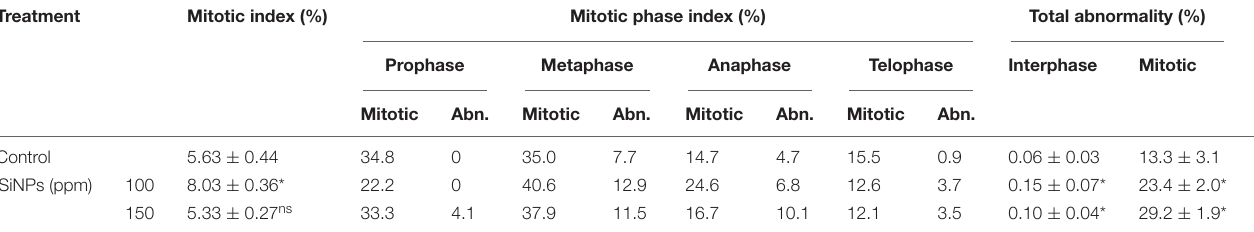
Treatment Mitotic index (%) Mitotic phase index (%) Total abnormality (%)